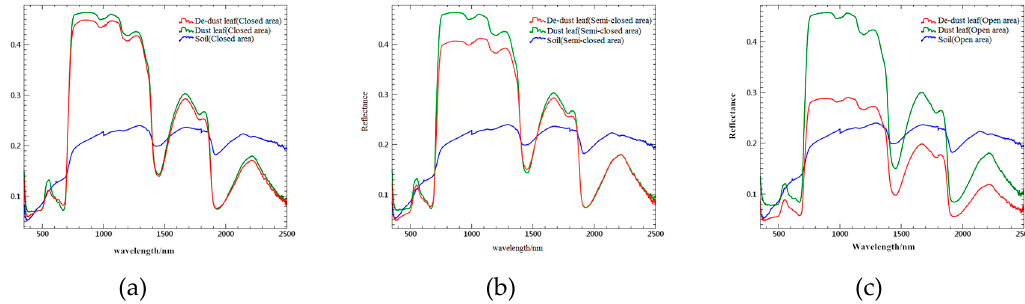
Figure 4. Changes in leaf spectral curves before and after cleaning: ( a ) closed area, ( b ) semi-closed area, and ( c ) open area.